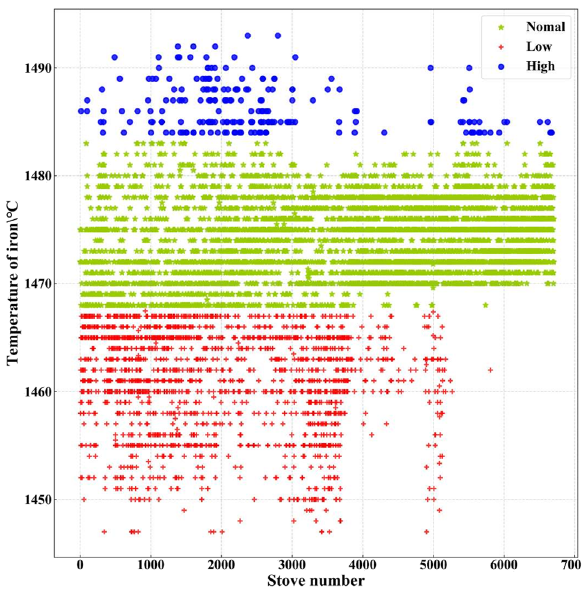
Figure 5: Result of K - means clustering.